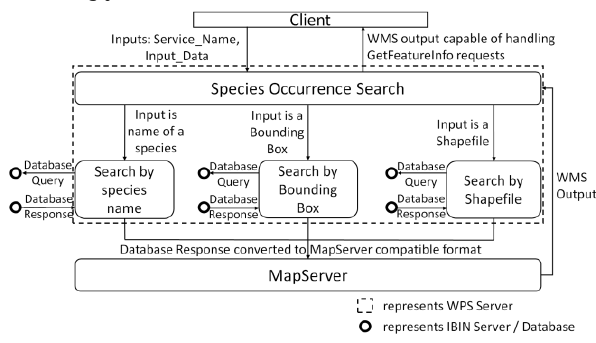
Figure 3. Species Occurrence Search WPS